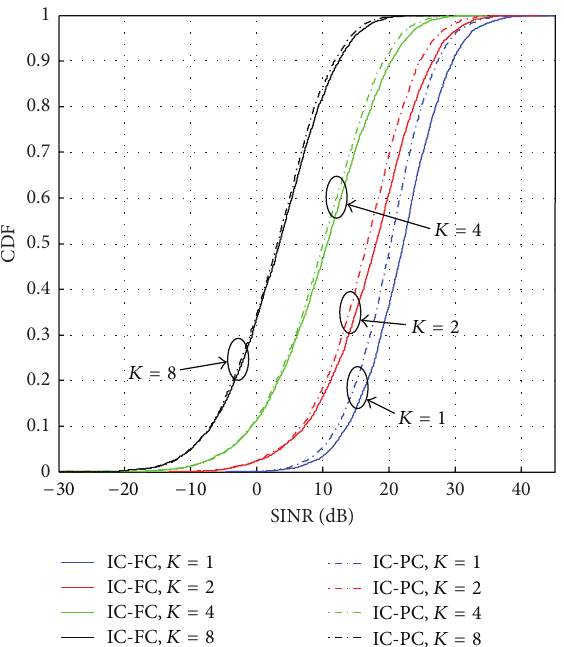
Figure 4: System level results of receive SINR CDF for multiple picocells